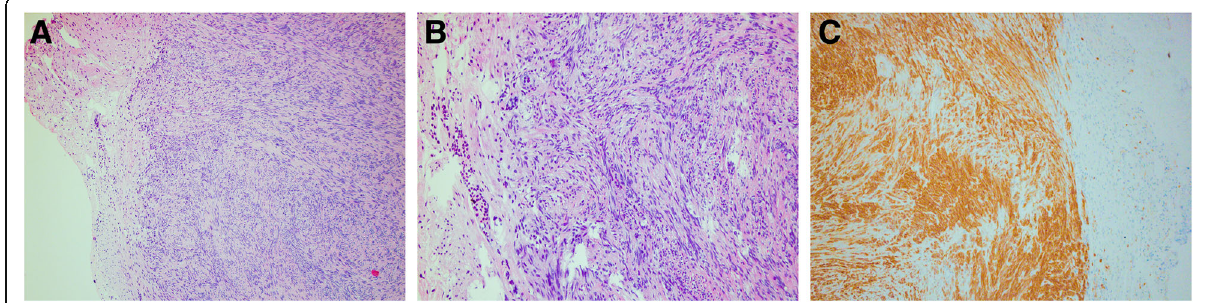
Fig. 4 Pathological and immunohistochemical features of gastric nodules. a : HE staining, 4 × 10 magnification. Tumor tissue was composed of spindle cells, which were without pleomorphism. b : HE staining, 10 × 10 magnification. Lymphomatous cells were of medium size and they were similar to the splenic lymphoma cells in the vessels of the normal gastric tissue. c : HE staining, 40 × 10 magnification. Immunohistochemically, the tumor cells were positive for